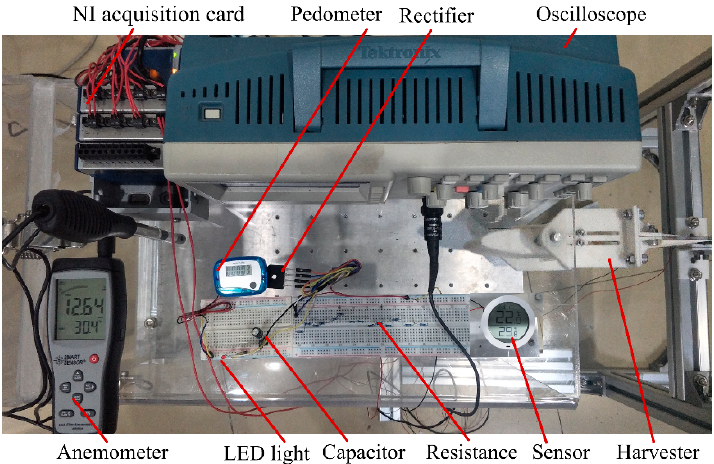
Figure 9. Photo of the energy-collecting and -storing circuit and the testing devices.